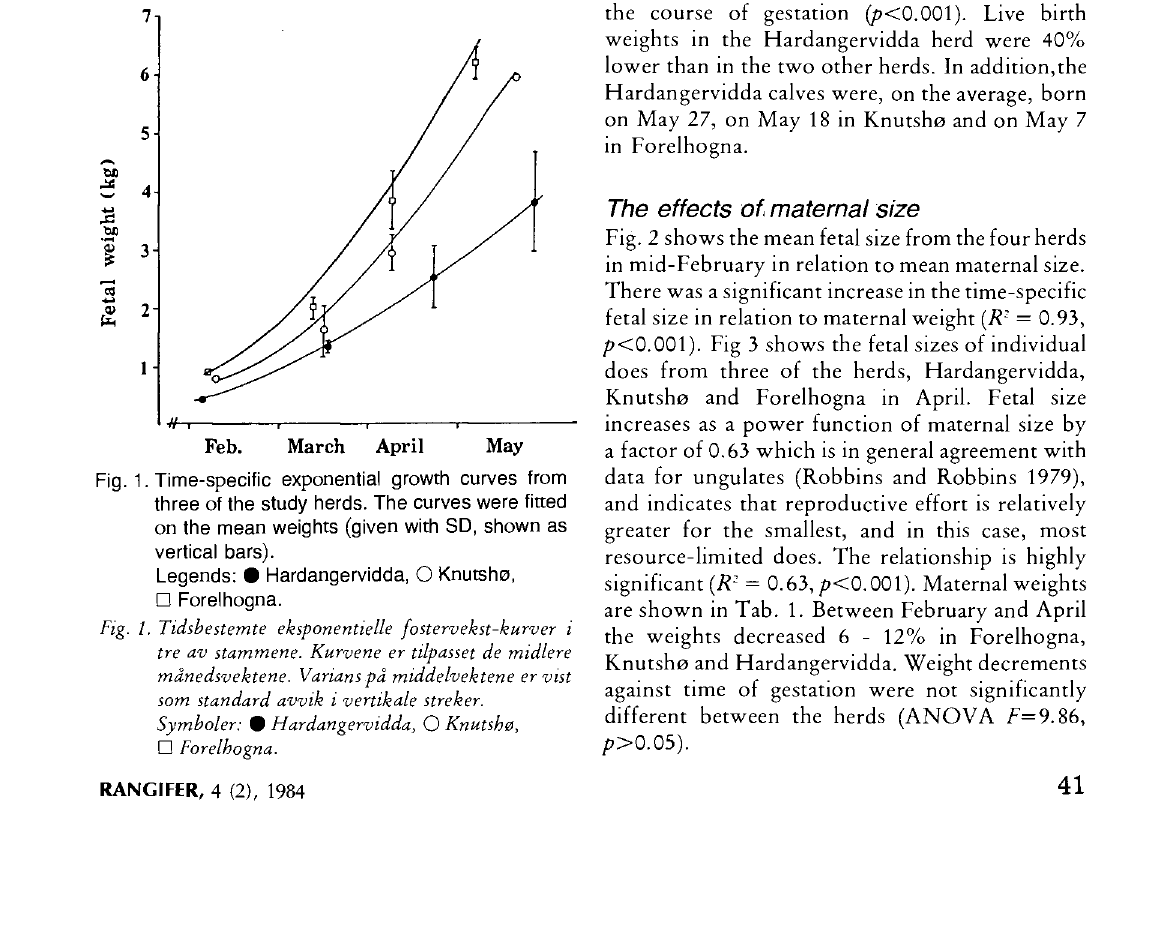
and the Knutshø calves or fetuses (p>0.05).